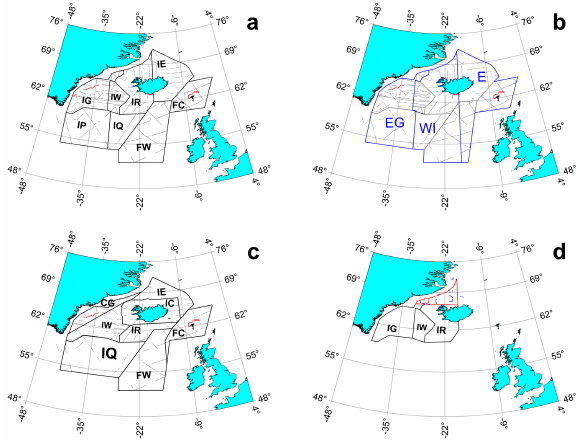
Figure 1. Stratification and realized effort at BSS<6 (a.) and regions used for the fin whale estimate (b.); post-stratification used for minke whales, with realized survey effort at BSS<4 (c.) and realized effort (BSS<6) in the fall capelin survey (d). Compromised transects are